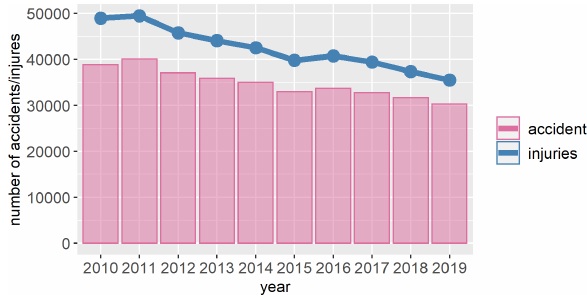
Figure 1: Number of accidents in Poland in 2010–2019